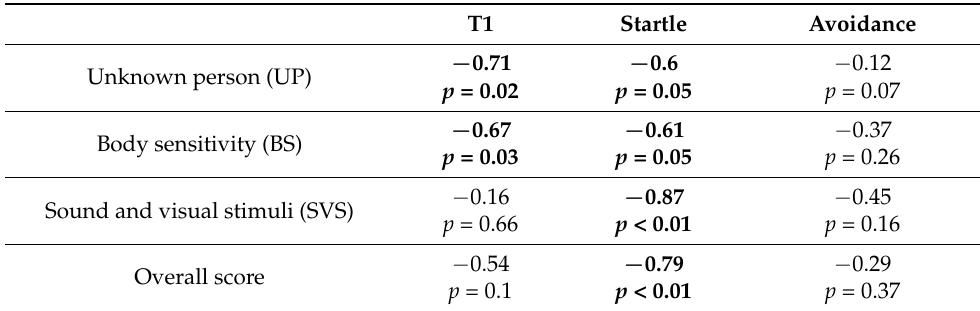
Table 3. Table of correlations between emotional reactivity test (ERT) scores with salivary cortisol (T1), startle and avoidance reaction.